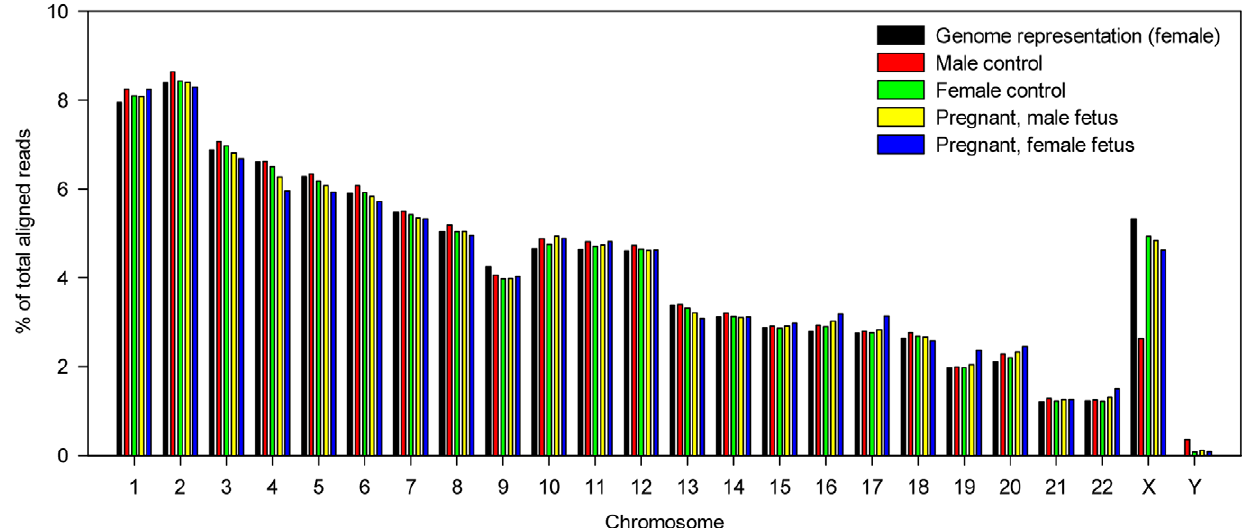
Figure 2. Genomic distribution urinary DNA fragments among the human chromosomes. The percentage of aligned PE reads per chromosome for the urine samples of a male control (red bars), a female control (green bars), a woman carrying male fetus (yellow bars) and a woman carrying female fetus (blue bars). The chromosomal representation as expected for the non-repeat-masked female diploid genome (black bars) is included for reference.